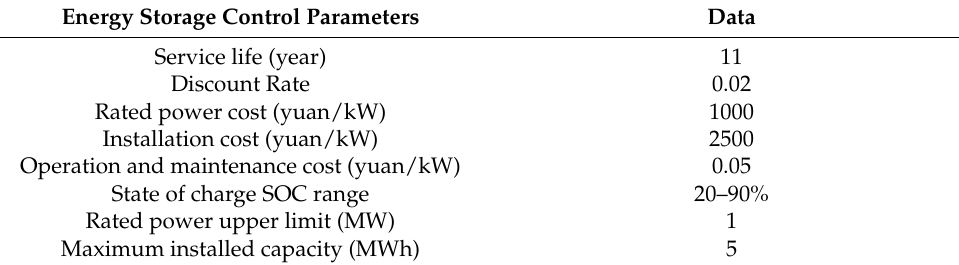
Table 3. Energy storage control parameter table.